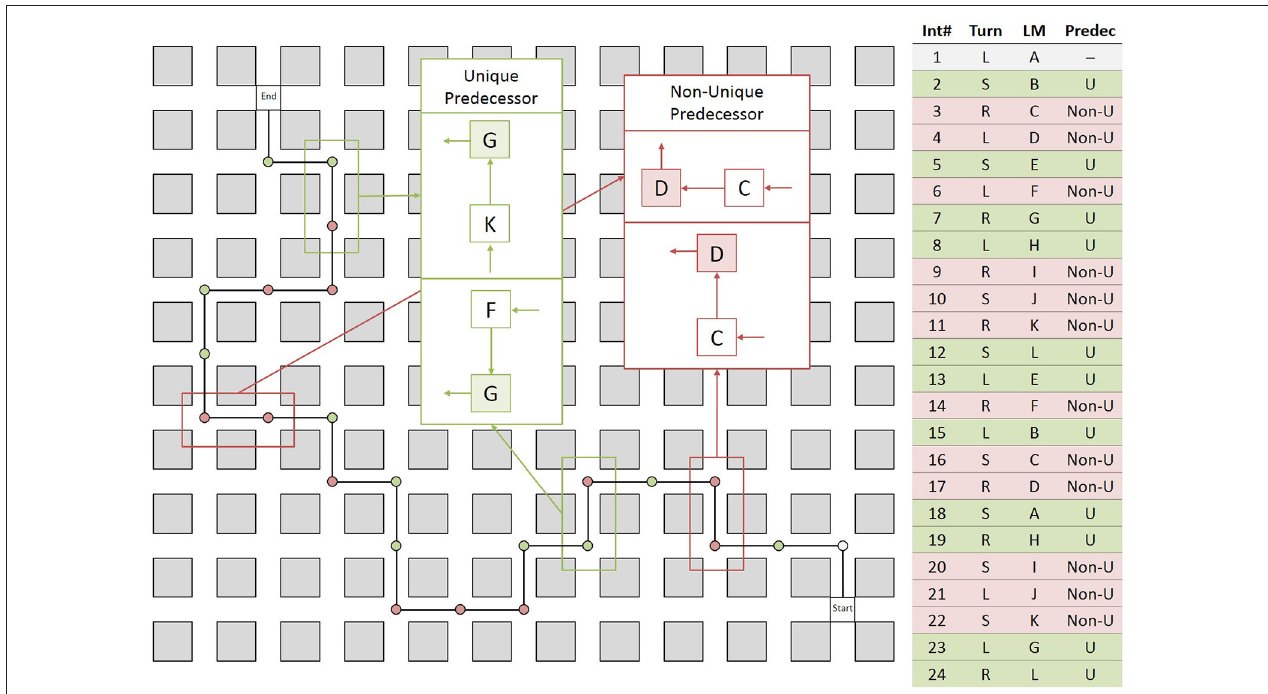
FIGURE 4 | Left: Schematic drawing of the route and example of unique predecessor (green) and non-unique predecessor intersections (red). Unique predecessor intersections are preceded by intersections with different landmark objects, while non-unique predecessor intersections are preceded by intersections with the same landmark object. The only way to disambiguate the two non-unique predecessor intersections is by taking into account the movement direction at the preceding intersections; Right: Table describing the route in detail. Int#: Number of intersection; Turn: Direction of turn left (L), right (R), straight (S); LM: Landmark objects, same letters indicating same object; Predec: Predecessor object unique (U) or non-unique